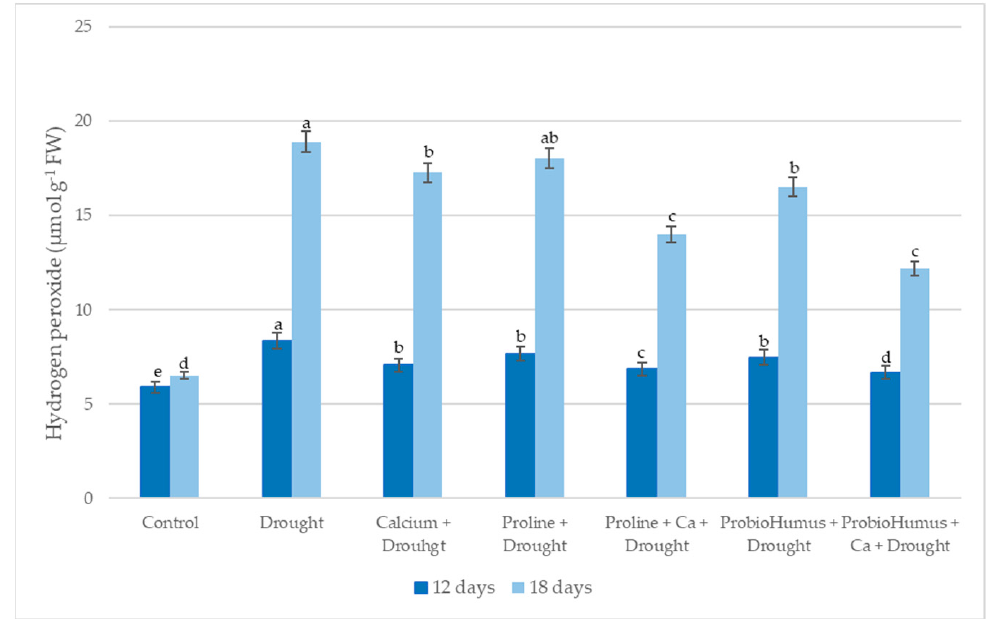
Figure 4. The effect of stress ‐ protecting compounds application and prolonged drought stress (12 and 18 days), on winter wheat H 2 O 2 content. Error bars represent the standard deviation of the mean. Control, Ca, proline, proline + Ca, ProbioHumus, and ProbioHumus + Ca indicates the type of application. Different lowercase letters in the same day of drought indicate statistically significant differences ( p < 0.05).